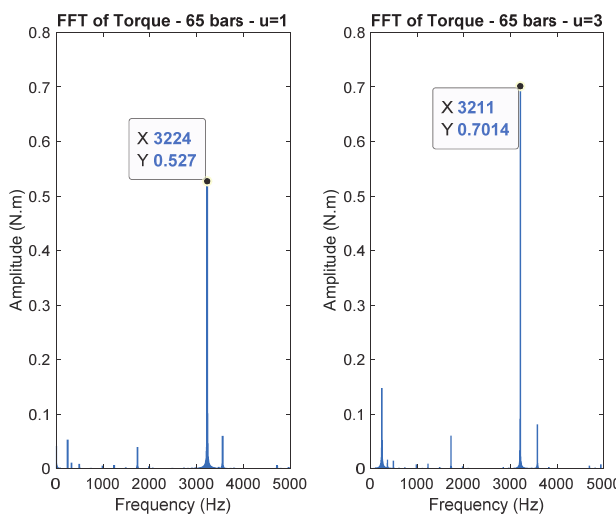
Figure 11. Comparison of the developed torque with 64 and 65 bars, five ‐ phase IM.